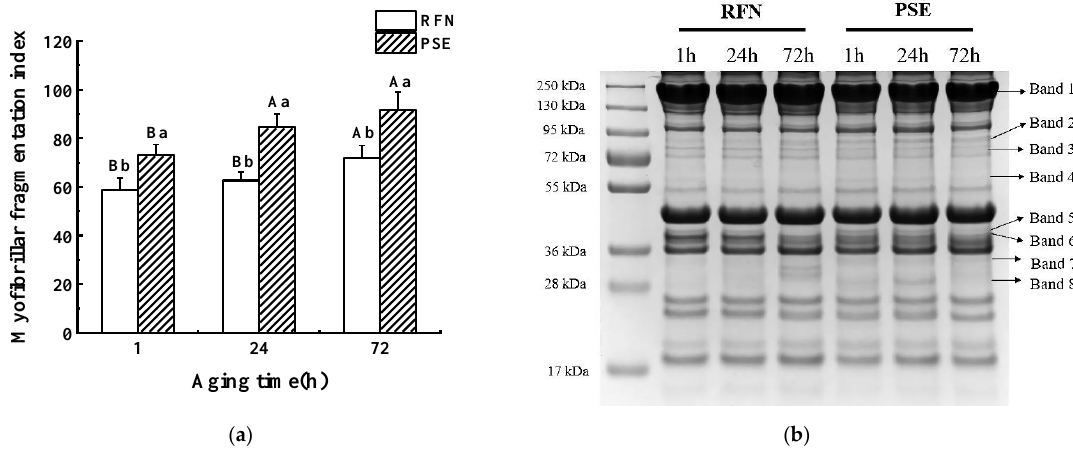
Figure 1. ( a ) Myofibrillar fragmentation index (MFI) value at 1 h, 24 h, and 72 h postmortem of pale, soft and exudative (PSE), and red, firm and non-exudative (RFN) meat; ( b ) representative image of the SDS-PAGE of the PSE and RFN samples during postmortem aging. a,b Values within the same aging time between different groups are significantly different ( p < 0.05). A,B Values within the same group at different aging times are significantly different ( p < 0.05). Table 2. Band intensities of representative myofibrillar protein among the pale, soft and exudative (PSE), and red, firm and non-exudative (RFN) groups during the postmortem aging. RFN